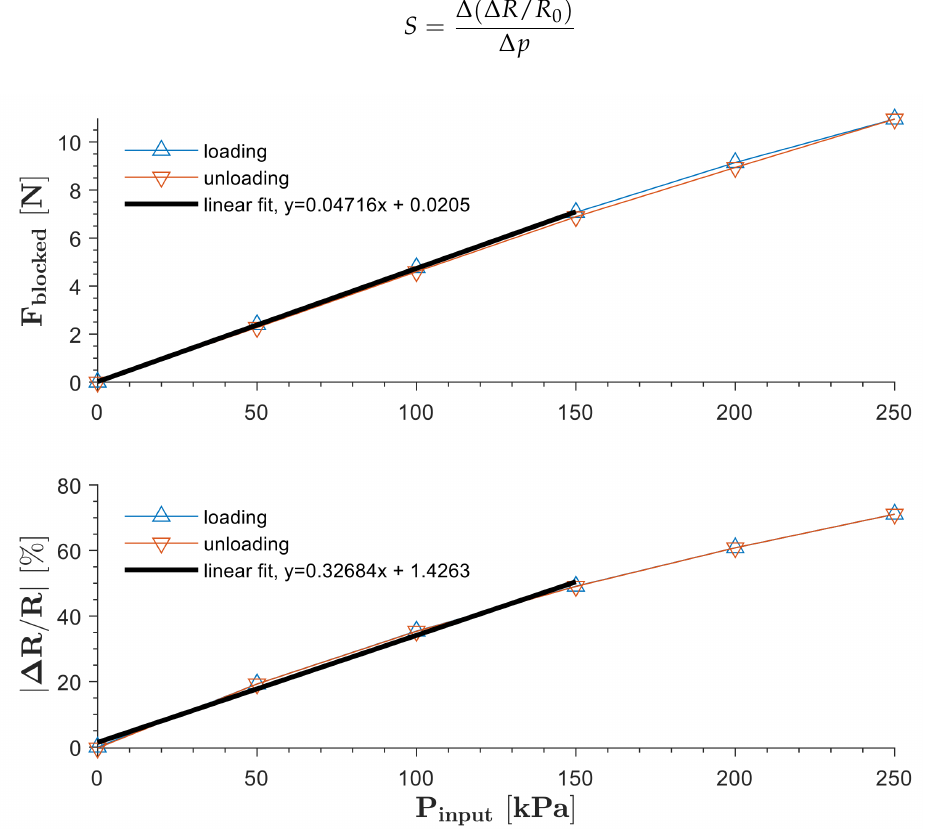
Figure 5. Linearity of SoHapS for blocked force and soft sensor response under stepping pressure inputs; linear fits for blocked force and sensor response (R 2 = 0.9999 and R 2 = 0.9942, respectively) are provided for up to 150 kPa due to the nonlinear response of the soft sensor above the pressure input of 150